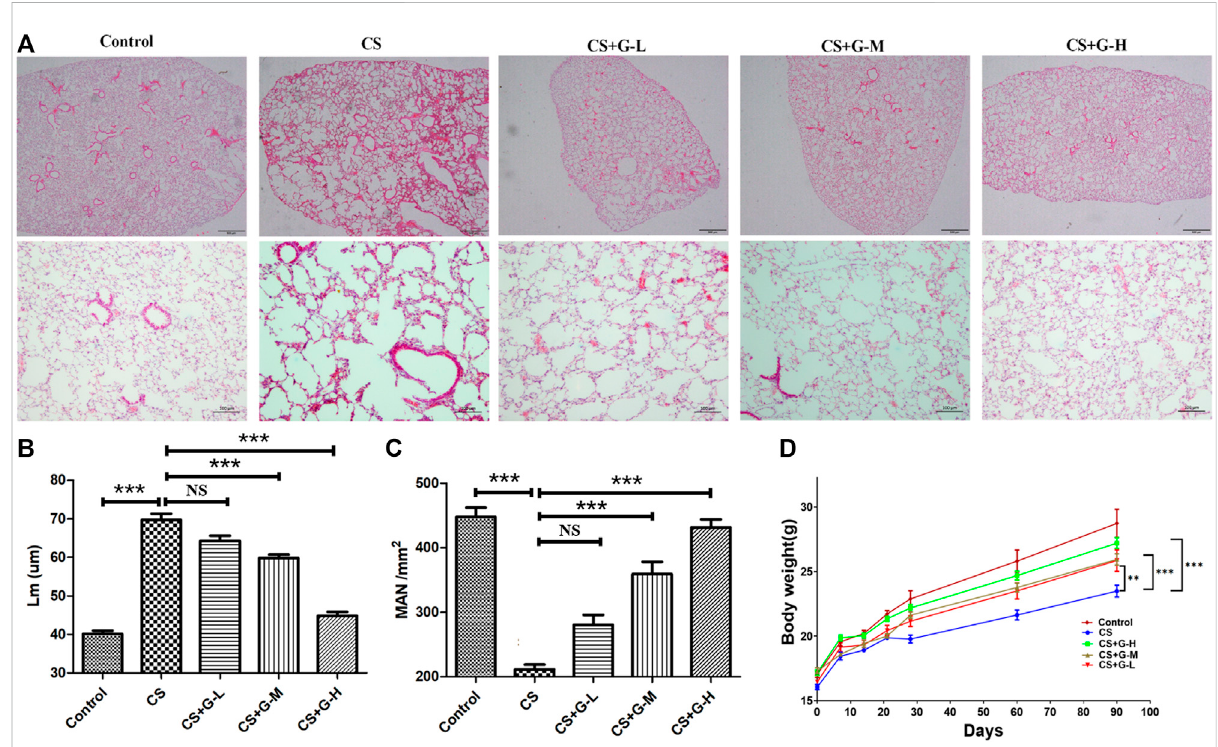
FIGURE 1 GHK-Cu alleviates cigarette smoke-induced emphysematous changes. (A) Photomicrograph of HE-stained slides for histological analysis of miceafterchronicexposuretocigarettesmokeorroomair.Representativeimagesofmicrographsat×20and×100magni fi cation. (B,C) Histological assessment of the sections was determined using Lm (B) and MAN (C) ( n = 6 mice/group). (D) The body weight was measured ( n = 10 – 12